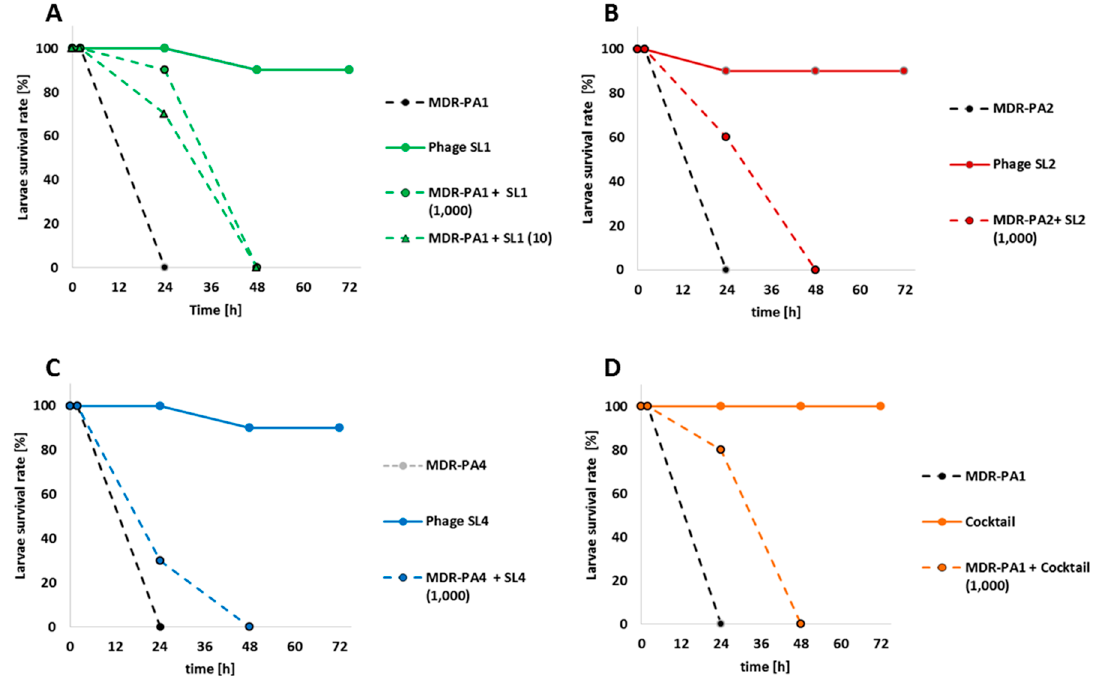
Figure 10. Percent Survival rate of larvae of Galleria mellonella after infection with multi-drug resistant P. aeruginosa strains (MDR-PA1, MDR-PA2 and MDR-PA4) and treatment with phages SL1 ( A ), SL2 ( B ), SL4 ( C ) or all phages together as a cocktail ( D ) 1 h post-infection. Numbers indicate MOI).